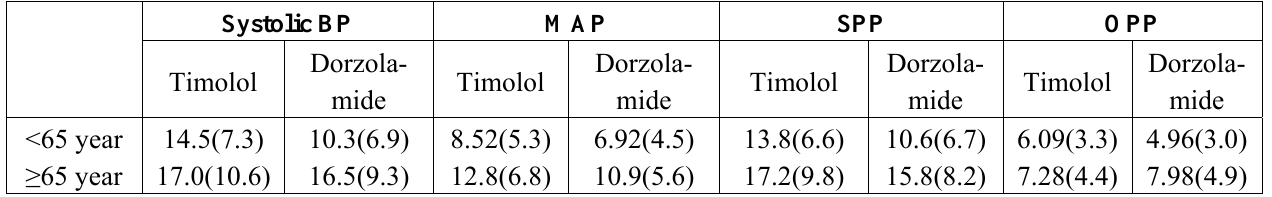
Table 5. Systolic BP, MAP, SPP and OPP fluctuations in different age groups.